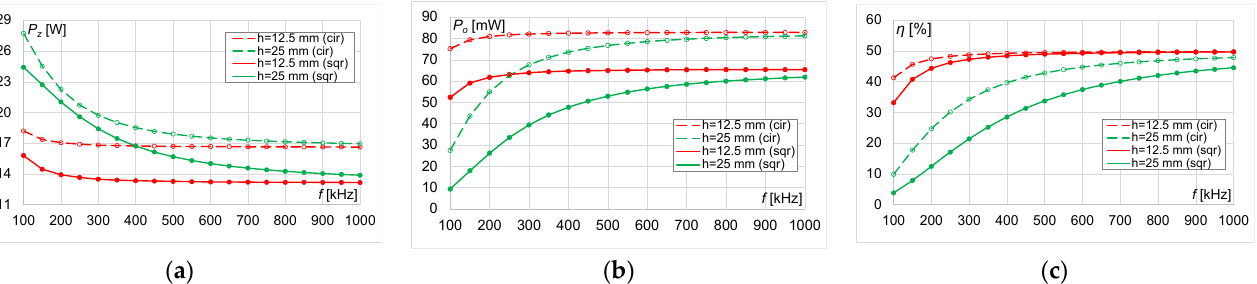
Figure 23. Results for circular and square coils with r = 25 mm and number of turns n = 40 at different distances ( h = 12.5 mm and h = 25 mm): ( a ) transmitter power, ( b ) receiver power and ( c ) power transfer efficiency.